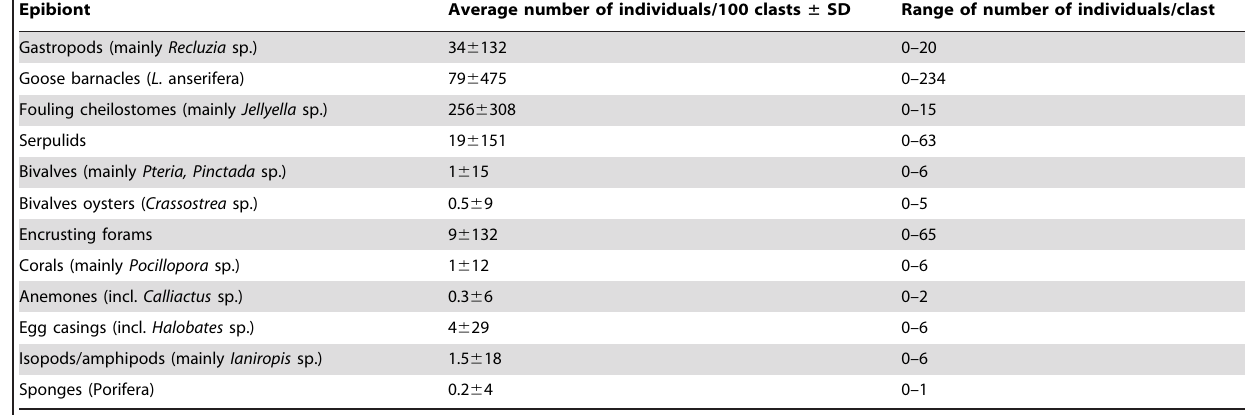
Table 2. Quantitative data for epibionts transported by the 2006–2007 pumice rafts.